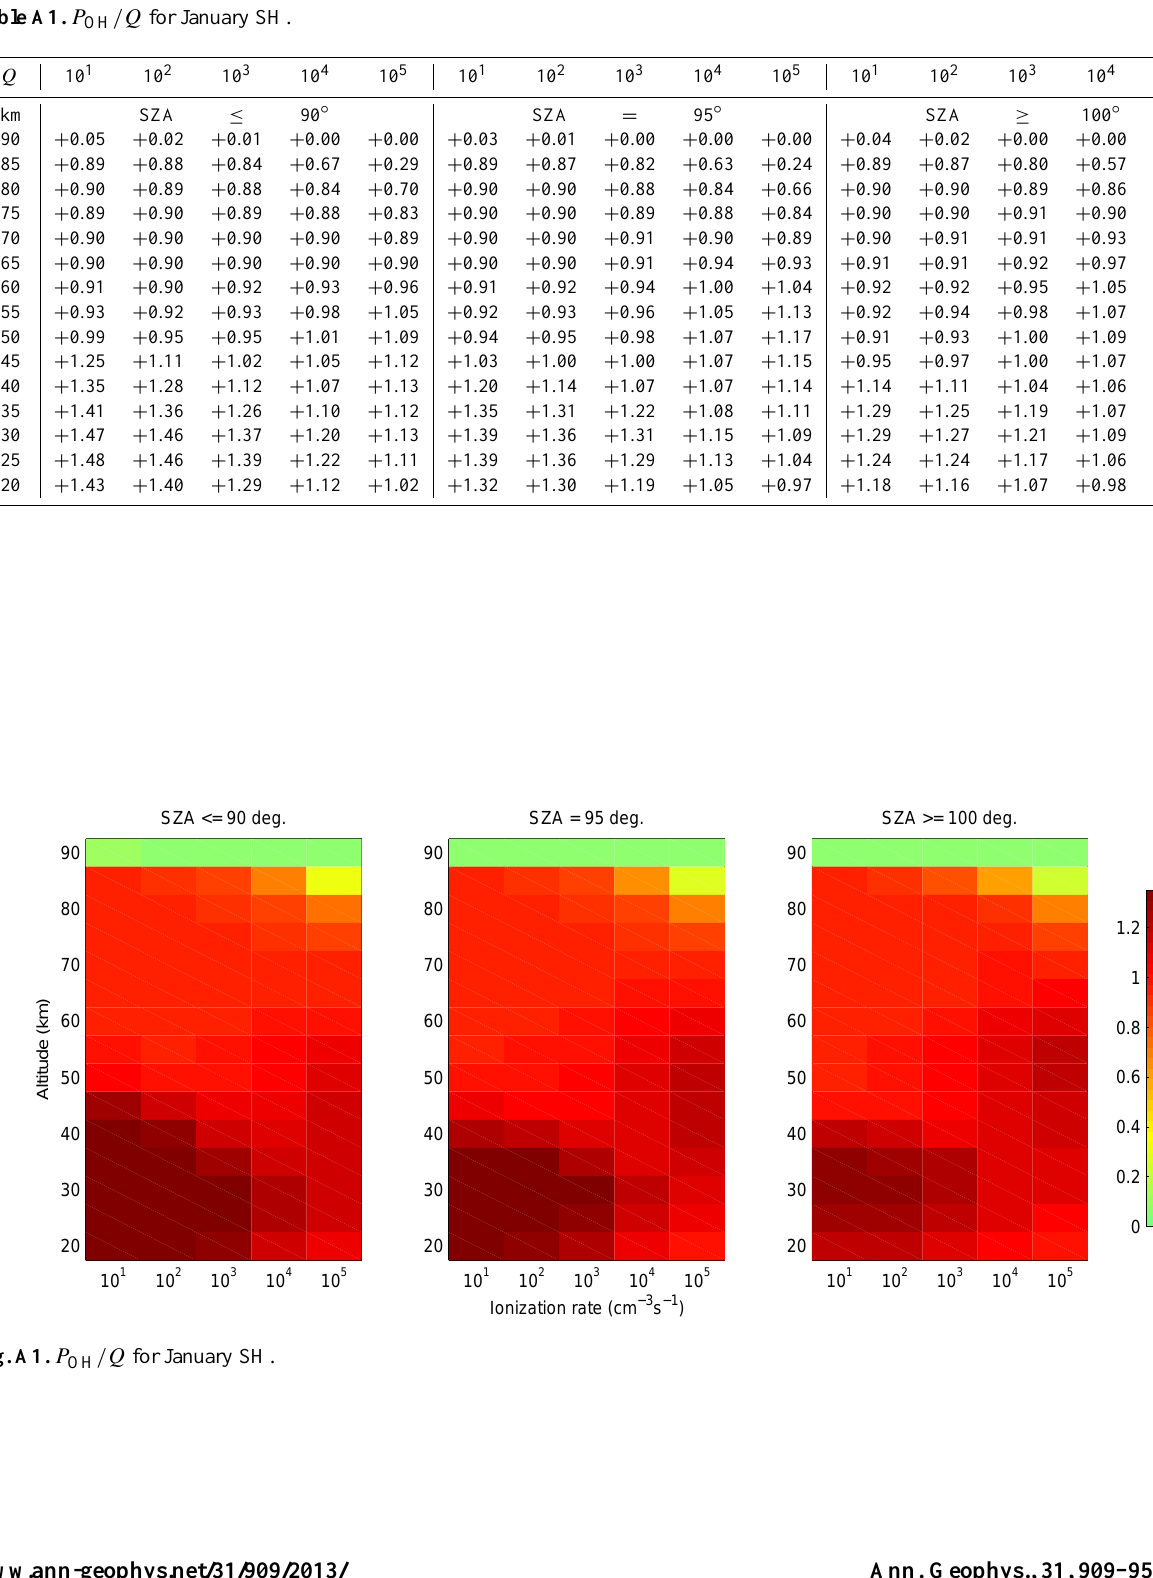
Table A1. P OH /Q for January SH.